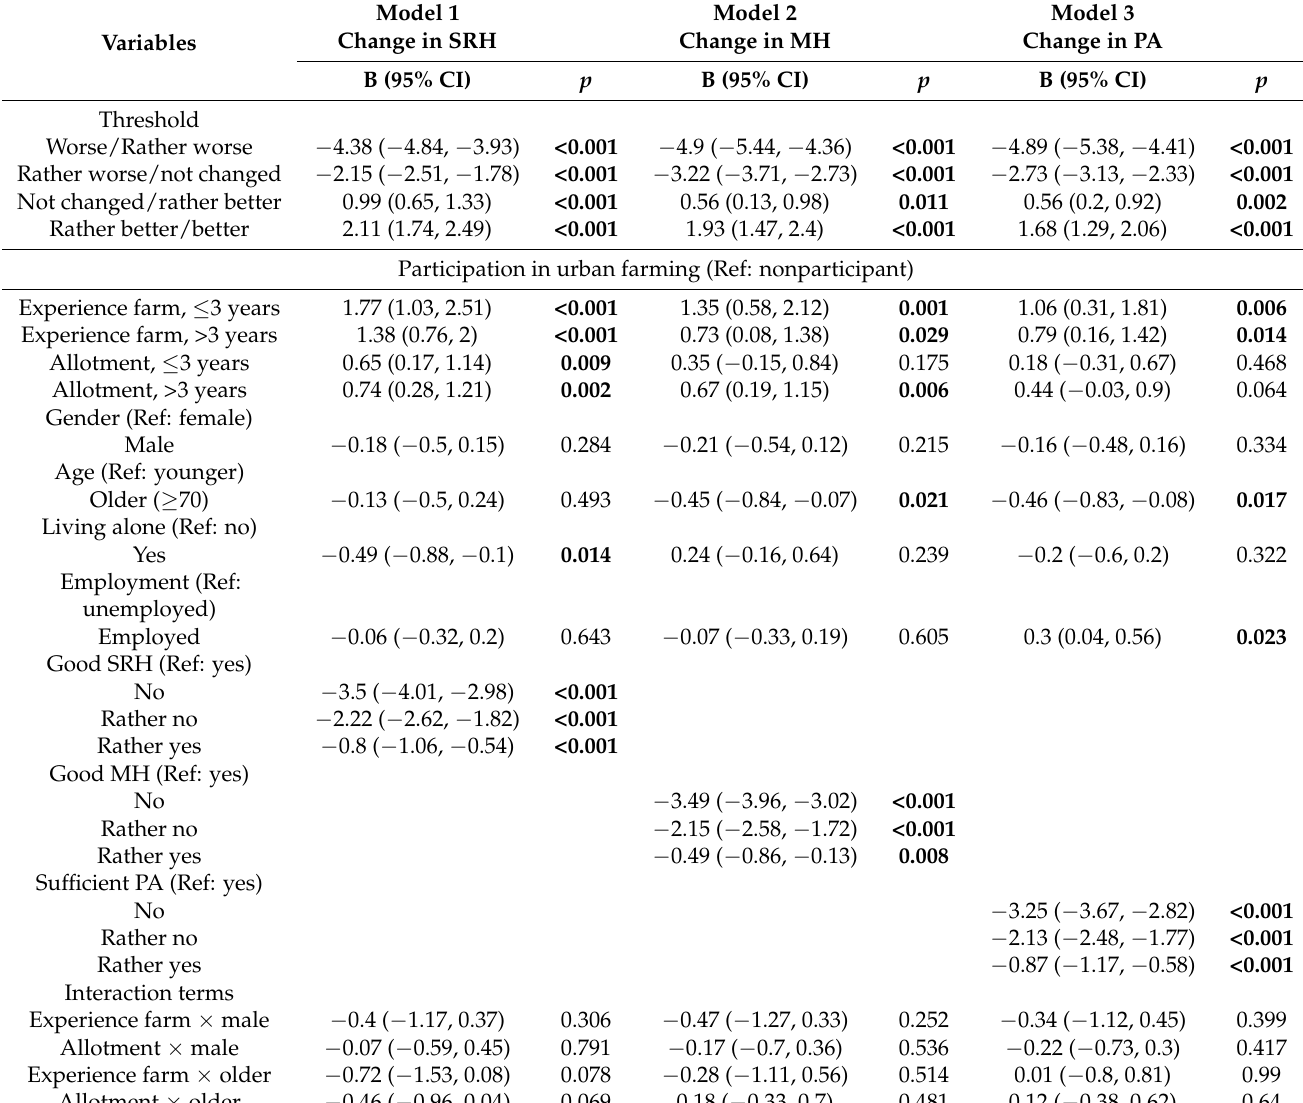
Table 2. The results of the ordinal logistic regression analyses (models